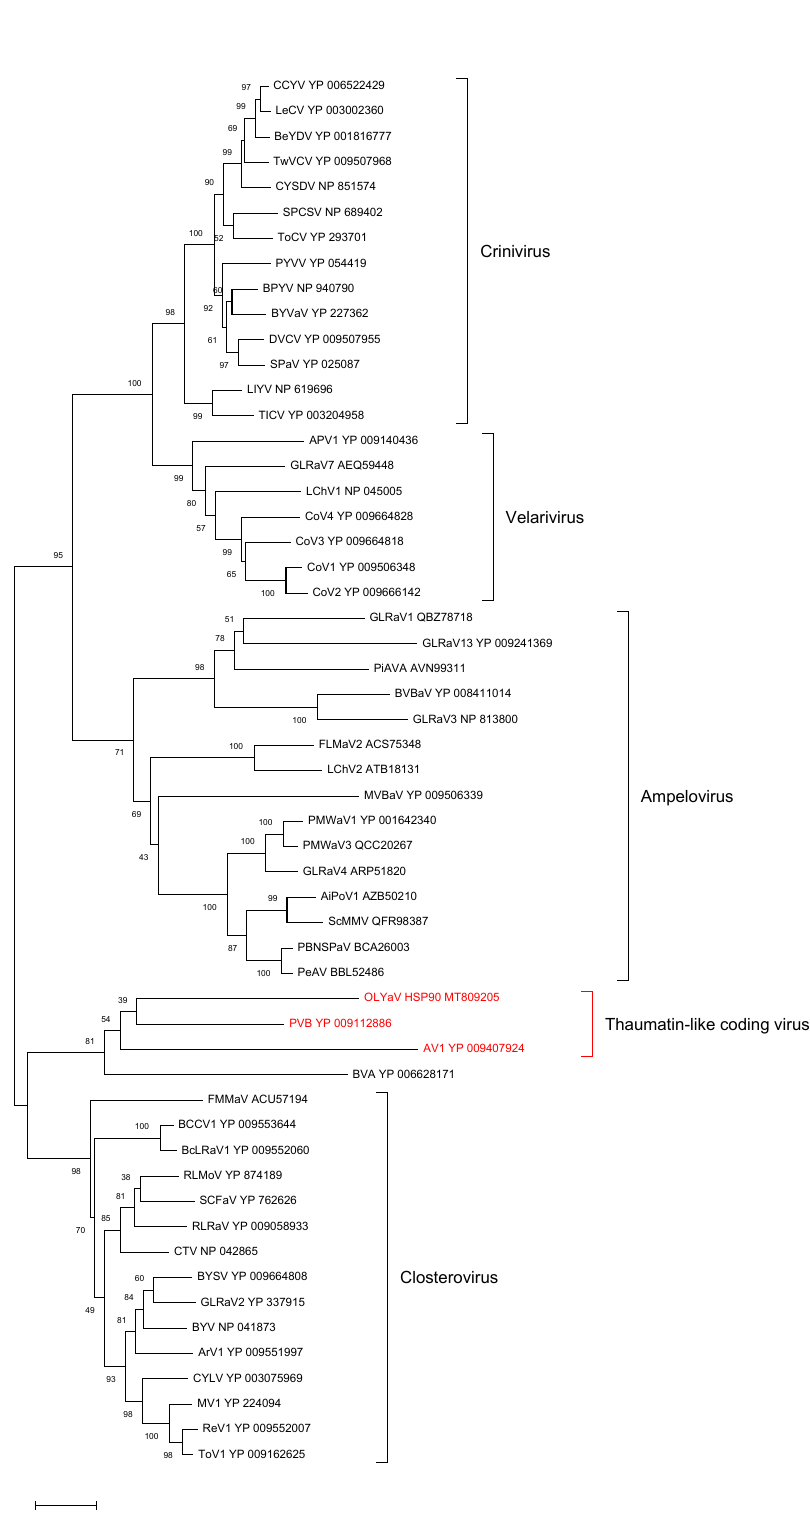
Figure 9. Maximum likelihood phylogenetic tree using the best substitution model by MEGA X of HSP90h from representative members of the family Closteroviridae . Proteins of the isolates are identified by their protein_id number. The scale bar shows the genetic distance. Bootstrap percentages (500 re ‐ samples) are indicated on the branches.